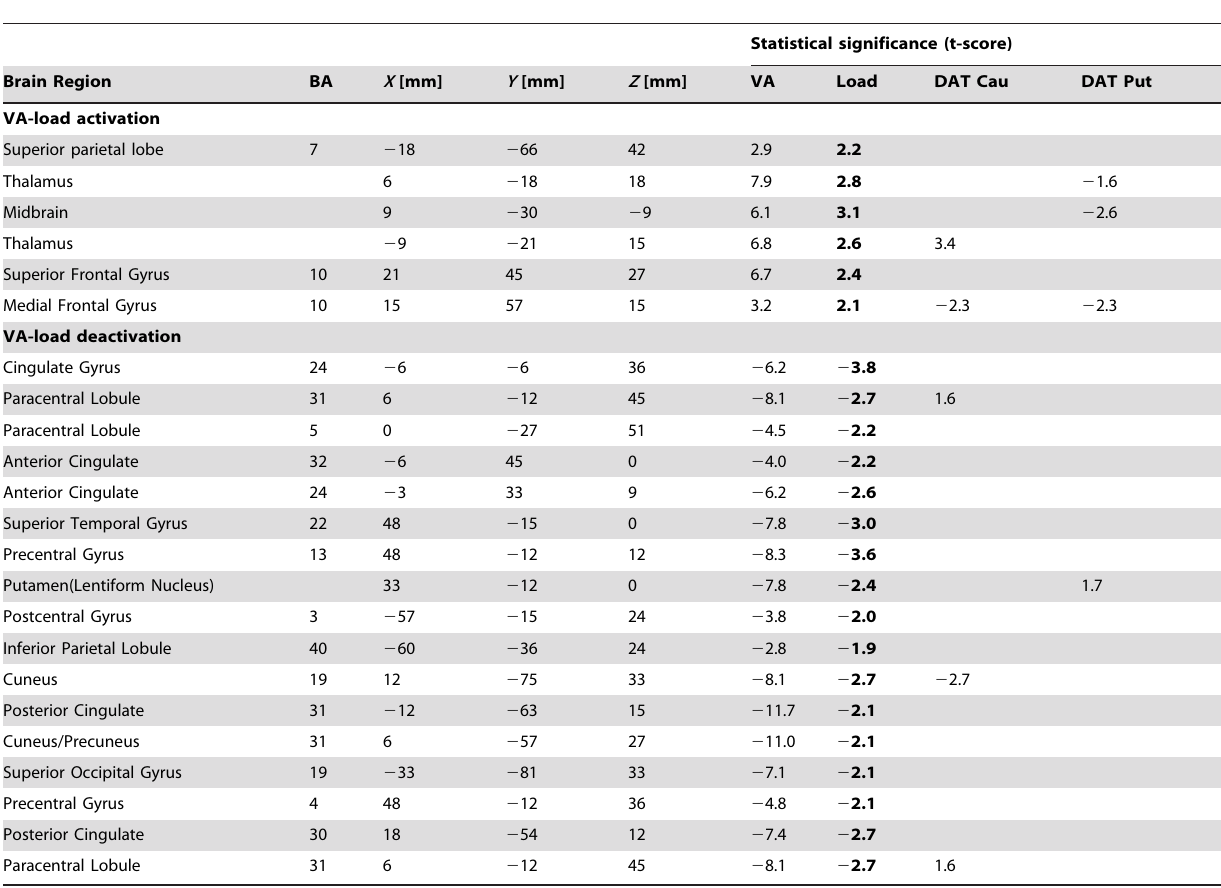
Table 2. Average statistical significance in regions-of-interest exhibiting VA-load